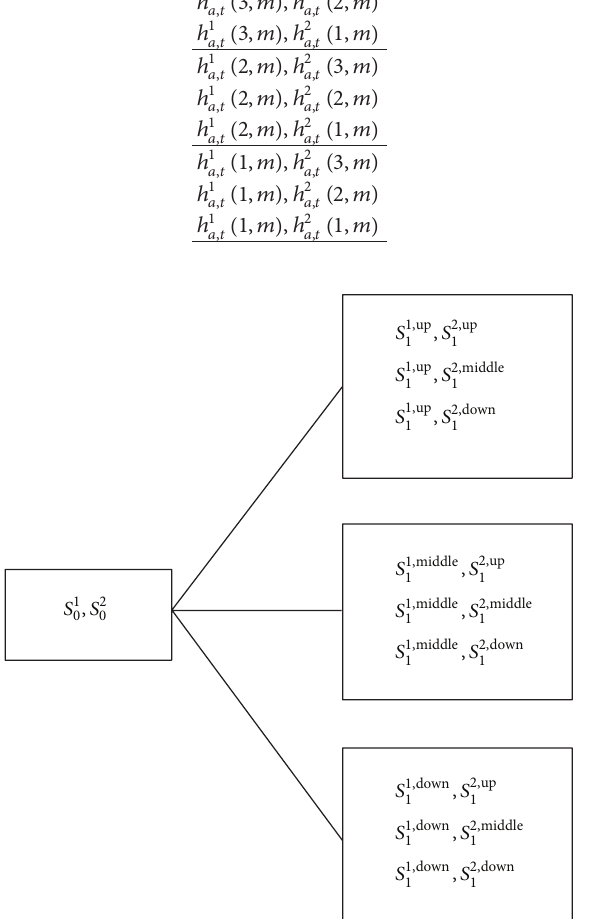
Figure 1: Two-asset GARCH